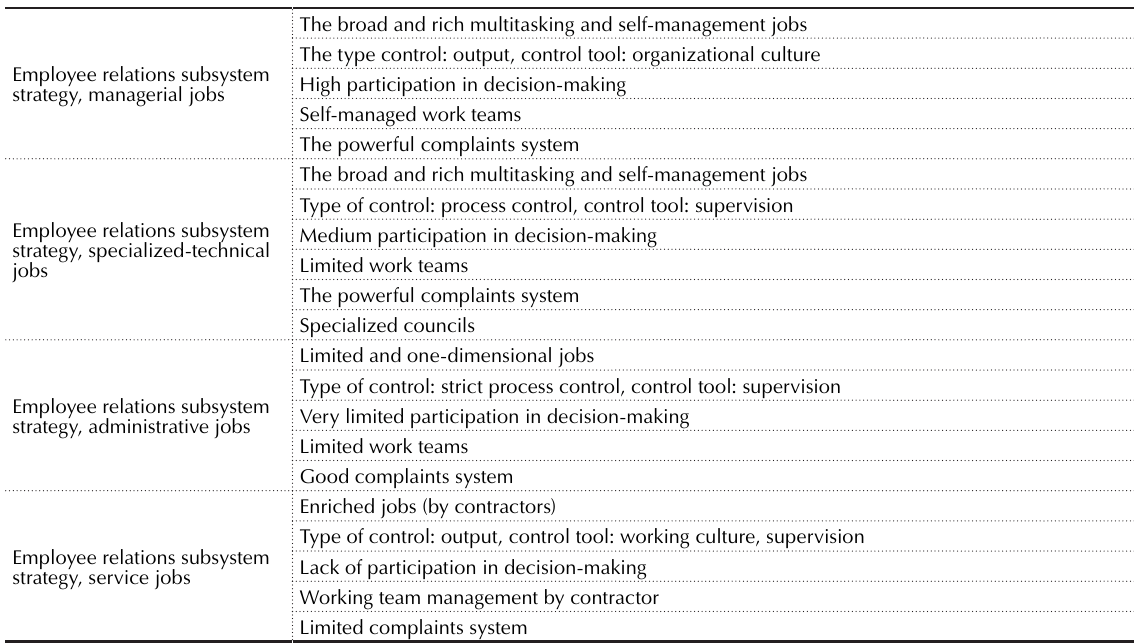
Table 11. The jobs employee relations sub-system strategy in the Civil Deputy of the Isfahan